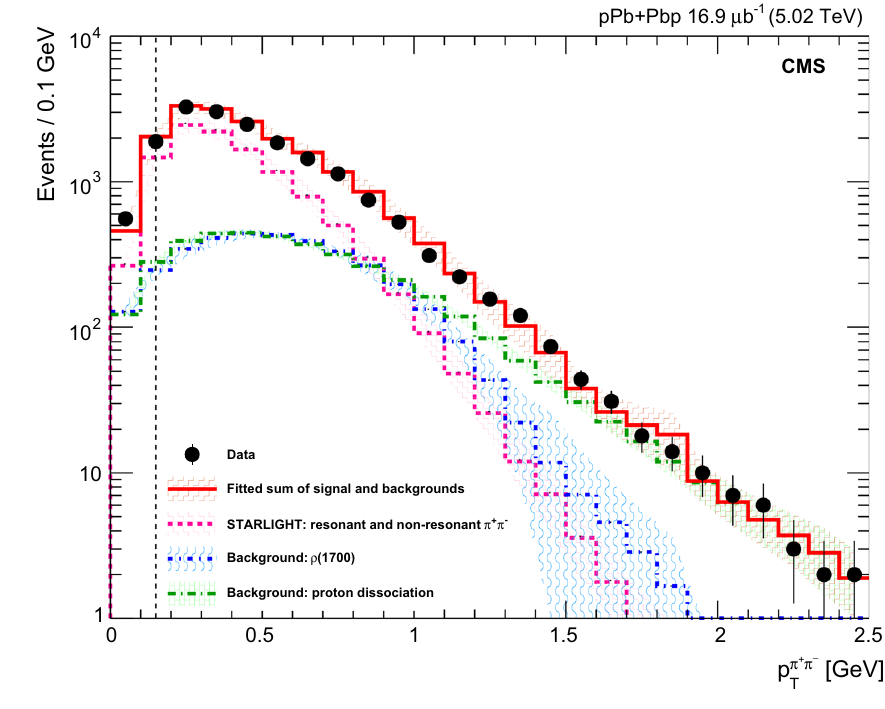
Fig. 2 The measured distribution of the reconstructed π + π − transverse momentum (full circles) together with the fitted sum of signal and backgrounds described in the text (red solid histogram). The starlight direct π + π − contribution (pink dotted histogram), the ρ ( 1700 ) background (blue dotted-short-dashed histogram), and the proton-dissociative contribution (green dotted-long-dashed histogram) are also shown. The shaded areas represent the systematic uncertainties. The region to the left of the dashed vertical line is not included in the analysis (see Sect. 5 for